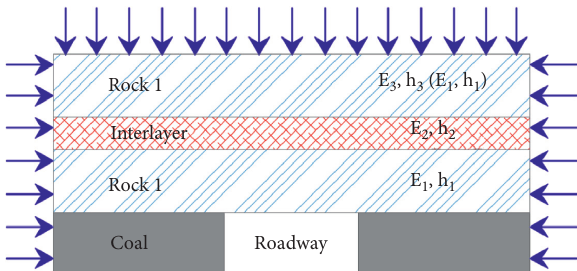
Figure 11: Simplified schematic diagram of roadway